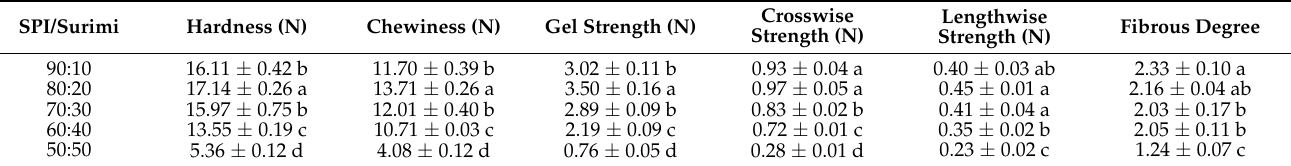
Table 1. Textural properties of the extrudates at different SPI and surimi ratios.